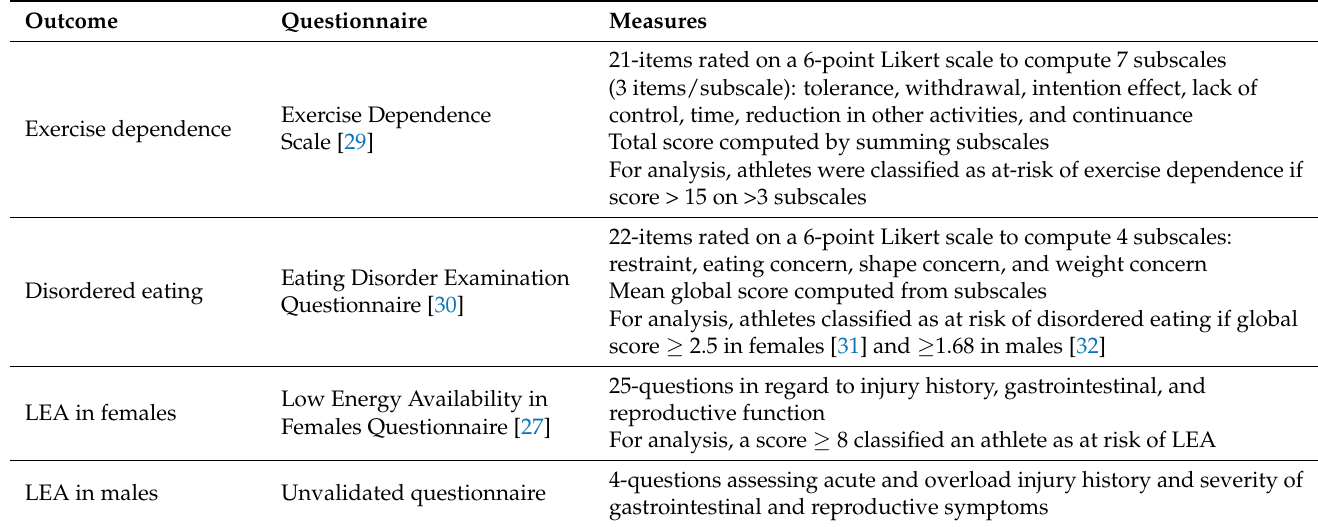
Table 1. Summary of questionnaires used to classify athletes as at risk of exercise dependence, disordered eating, risk of low energy availability, and associated health